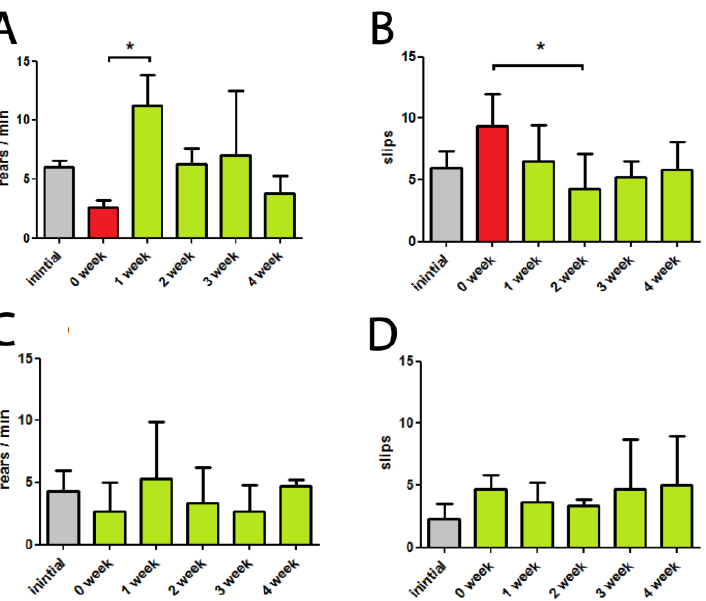
Figure 4. Effects of high CO 2 inhalation treatment on rotenone-injected ( A , B ) and control ( C , D ) mice. 0-week denotes the beginning of treatment, after 2 weeks of rotenone exposure. ( A – C ) The number of rears per minute in a cylinder test, * p < 0.05 ( B – D ) The number of paw slips (mistakes) in a beam walking test, * p < 0.05.